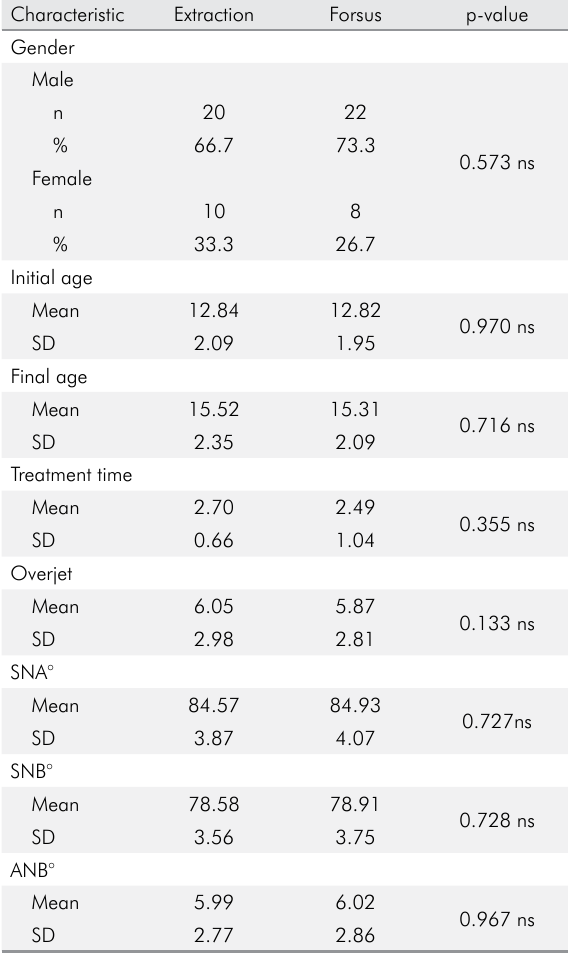
Table 1. Comparison of characteristics of the sample in the two treatment protocols performed by independent